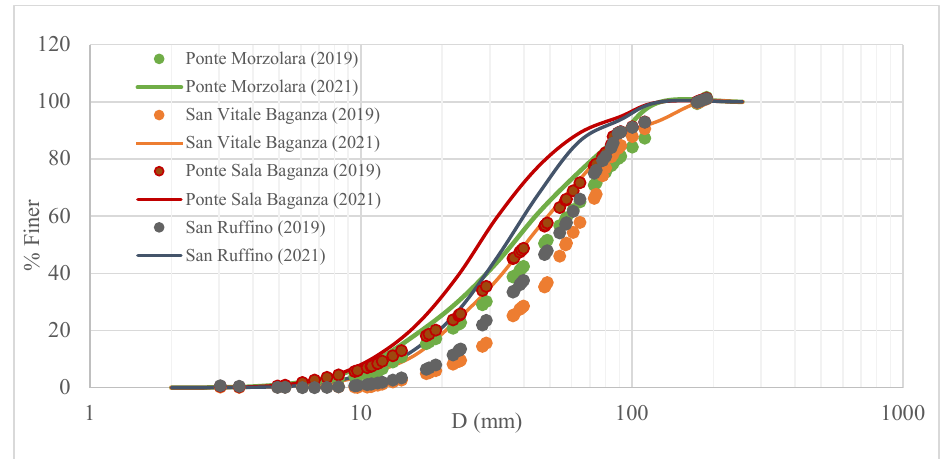
Figure 9. The comparison of the exposed fluvial sediments in the superficial layer from 2019 and 2021 (photogrammetric technique) at all sections.